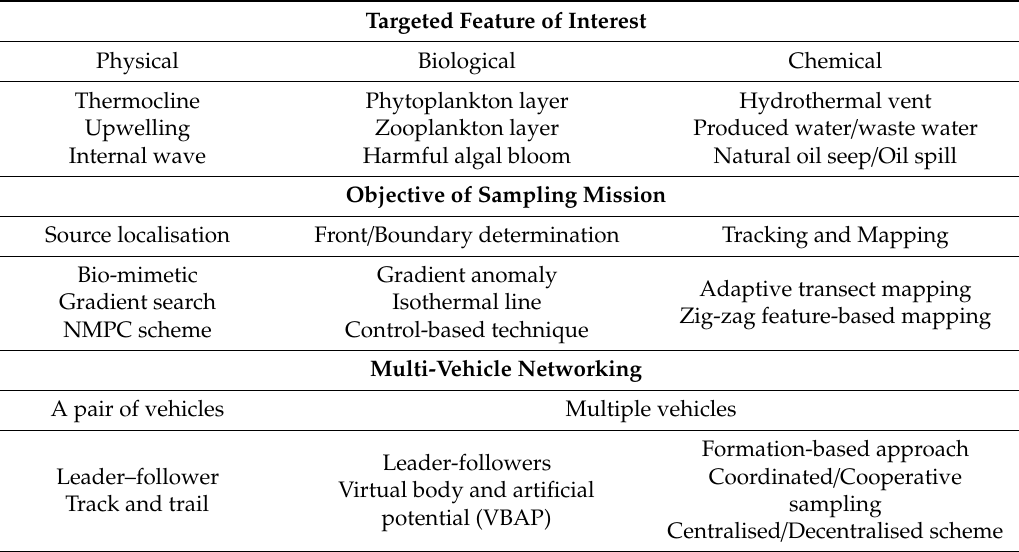
Table 1. Categories of adaptive sampling.